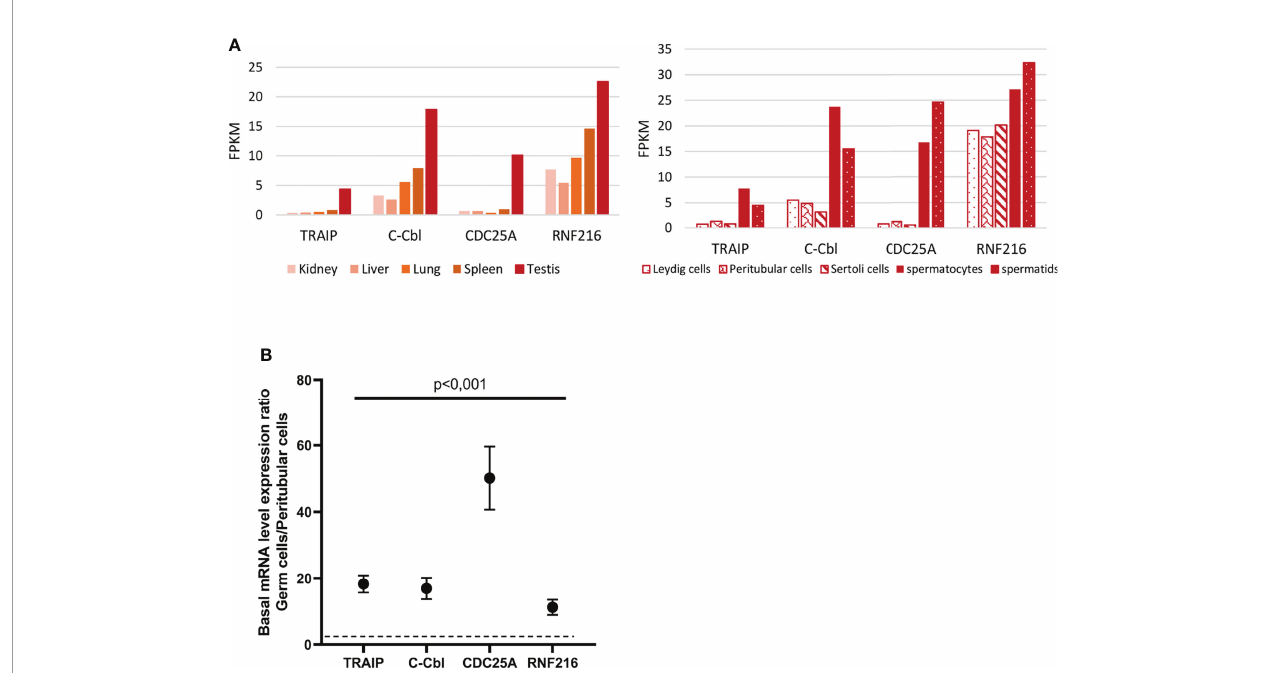
FIGURE 6 | Expression of a selection of PRR-signaling repressors in human testis and isolated testicular cells. (A) mRNAs expression of PRR-signaling repressors in human testis and testicular cells, based on RNA-seq data base analysis (23, 24) (B) Selected PRR-signaling repressors were quanti fi ed by RT-qPCR in human testicular germ cells and peritubular cells isolated from 5 different donors. The graph shows expression ratios between germ cells and peritubular cells. Each dot corresponds to the mean value ± SEM. Mann-Whitney non-parametric